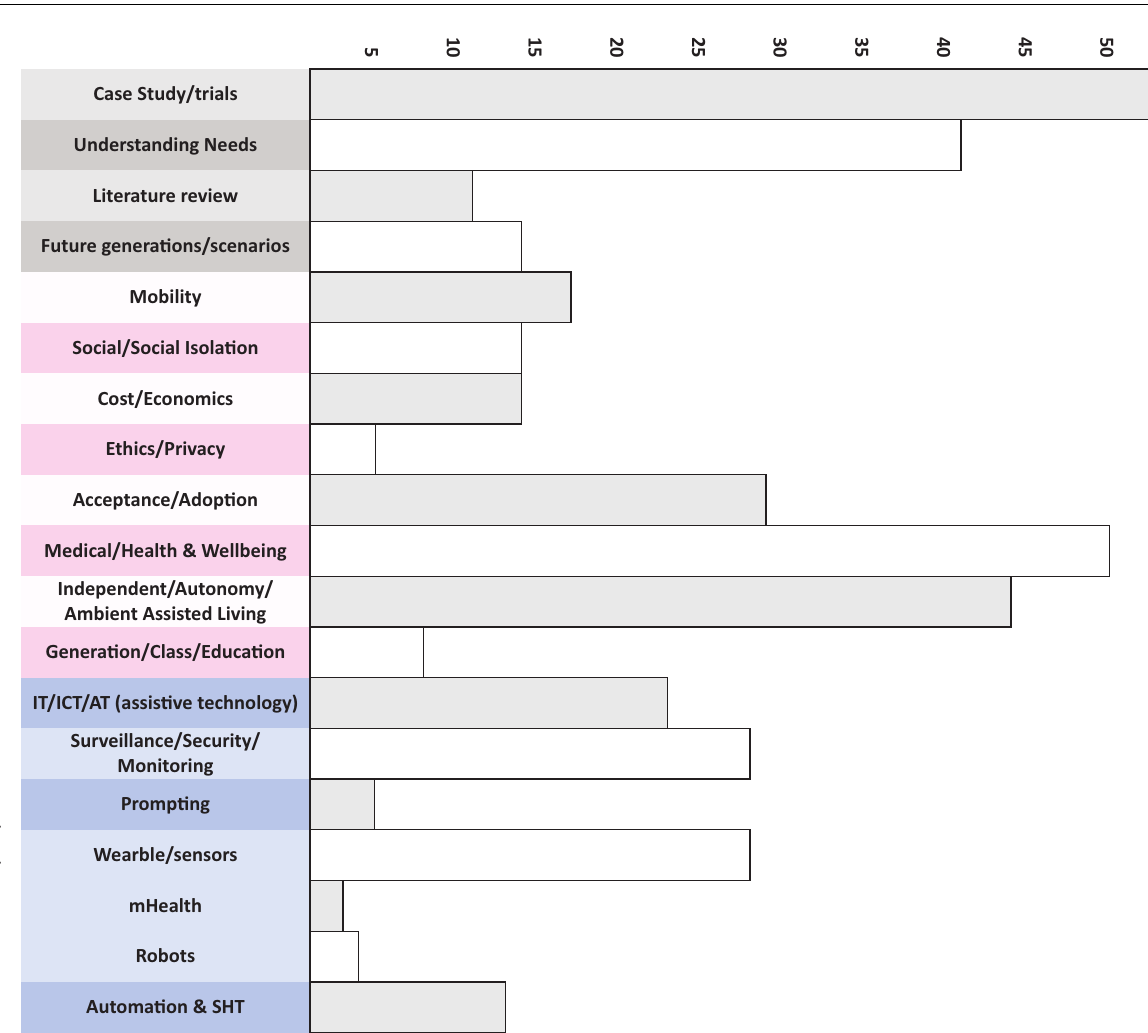
Figure 3. Summary of literature review (round 2). Note: Seven technologies are highlighted in